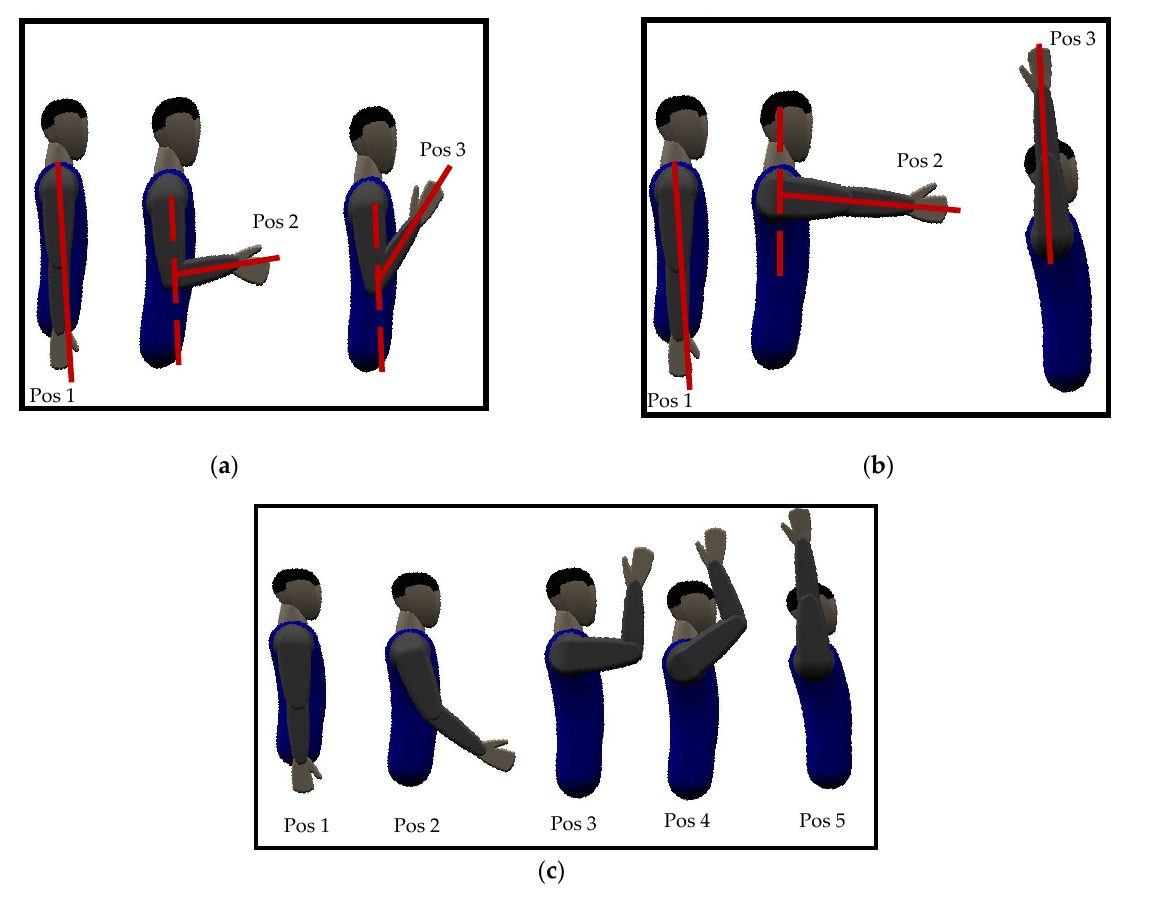
Figure 5. Dynamic motions of upper limb ( a ) elbow, ( b ) shoulder, and ( c ) ES movement. Table 2. Data collection